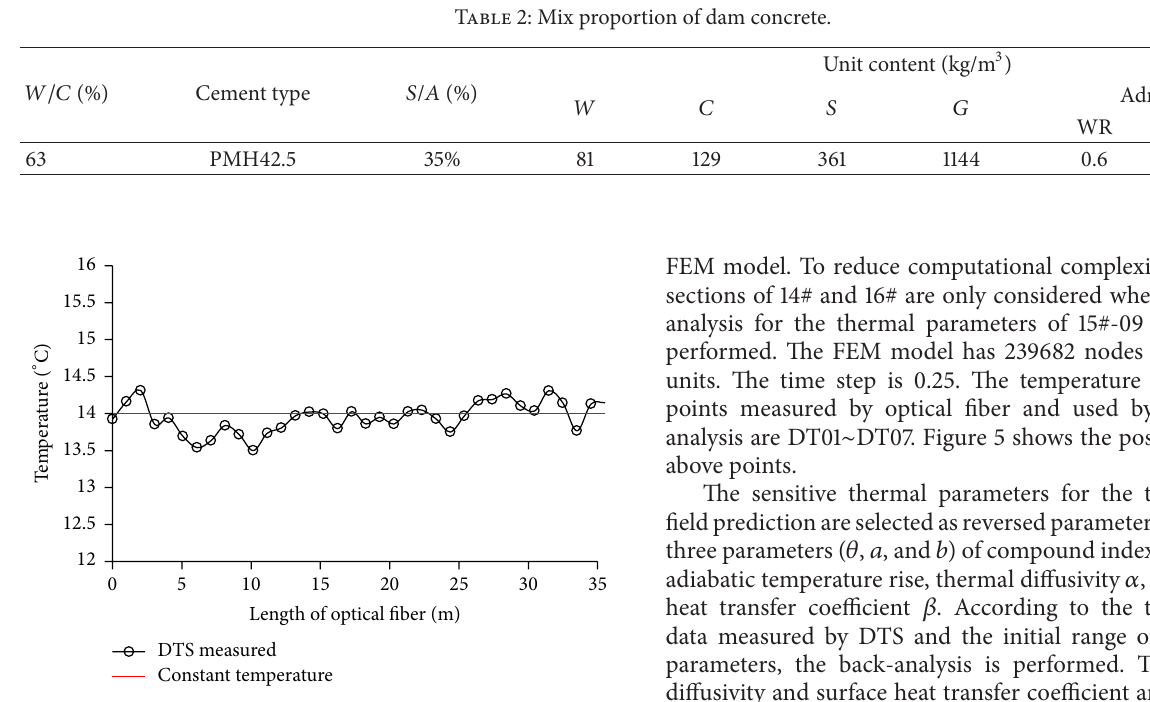
Figure 4: Comparison of DTS measured temperature and constant temperature of